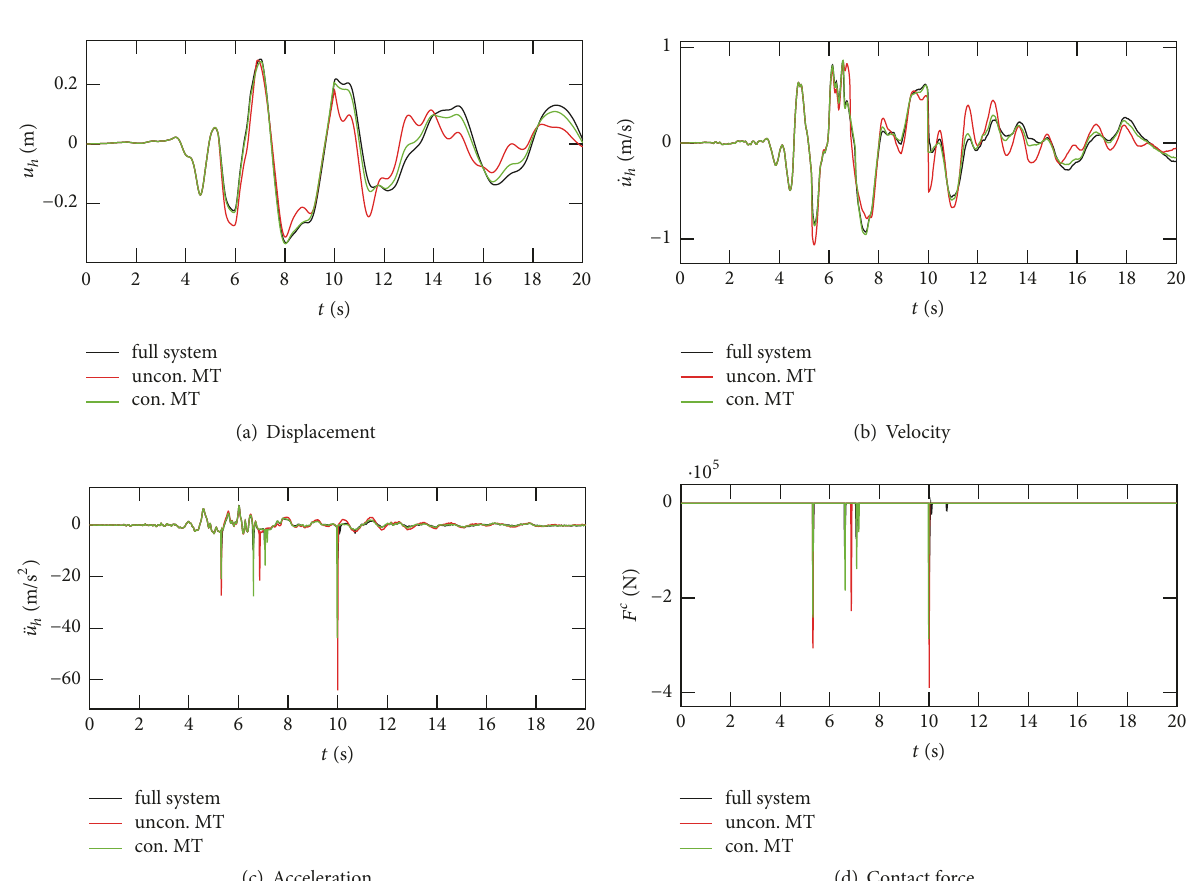
Figure 13: Results for the displacement, the velocity, and the acceleration as well as the contact force under seismic excitation